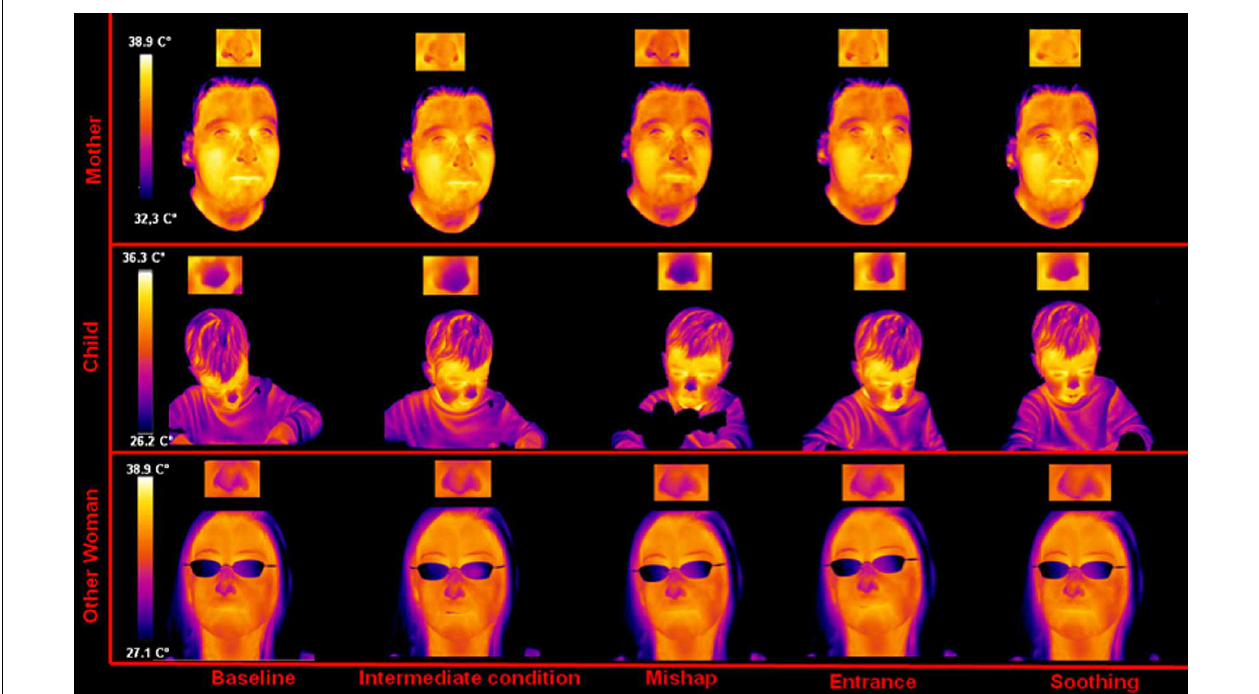
condition or a social interaction. Facial temperature variations are shown across experimental phases. Such variations, expression of the sympathetic activity may regard not only the average value but also the spatial distribution of the temperature across the regions of